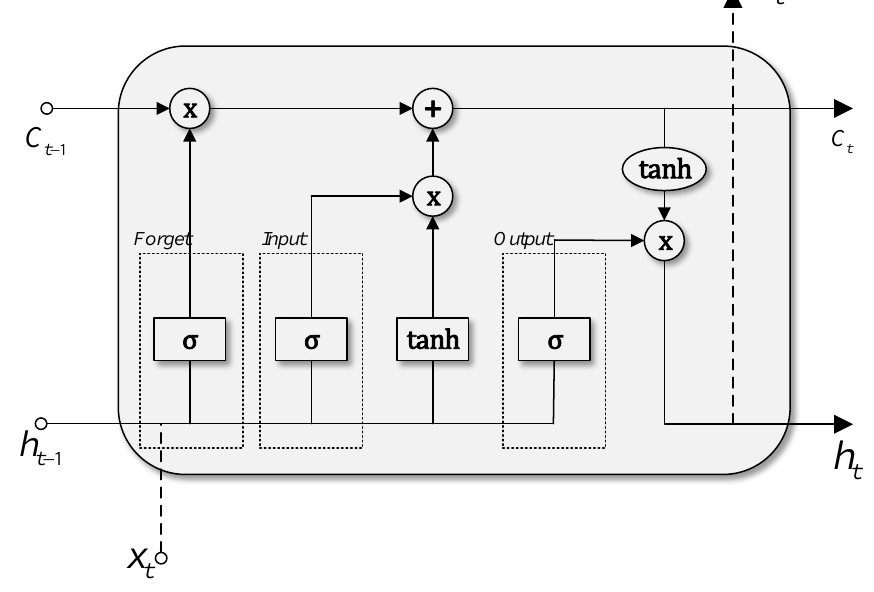
Figure 9. LSTM memory